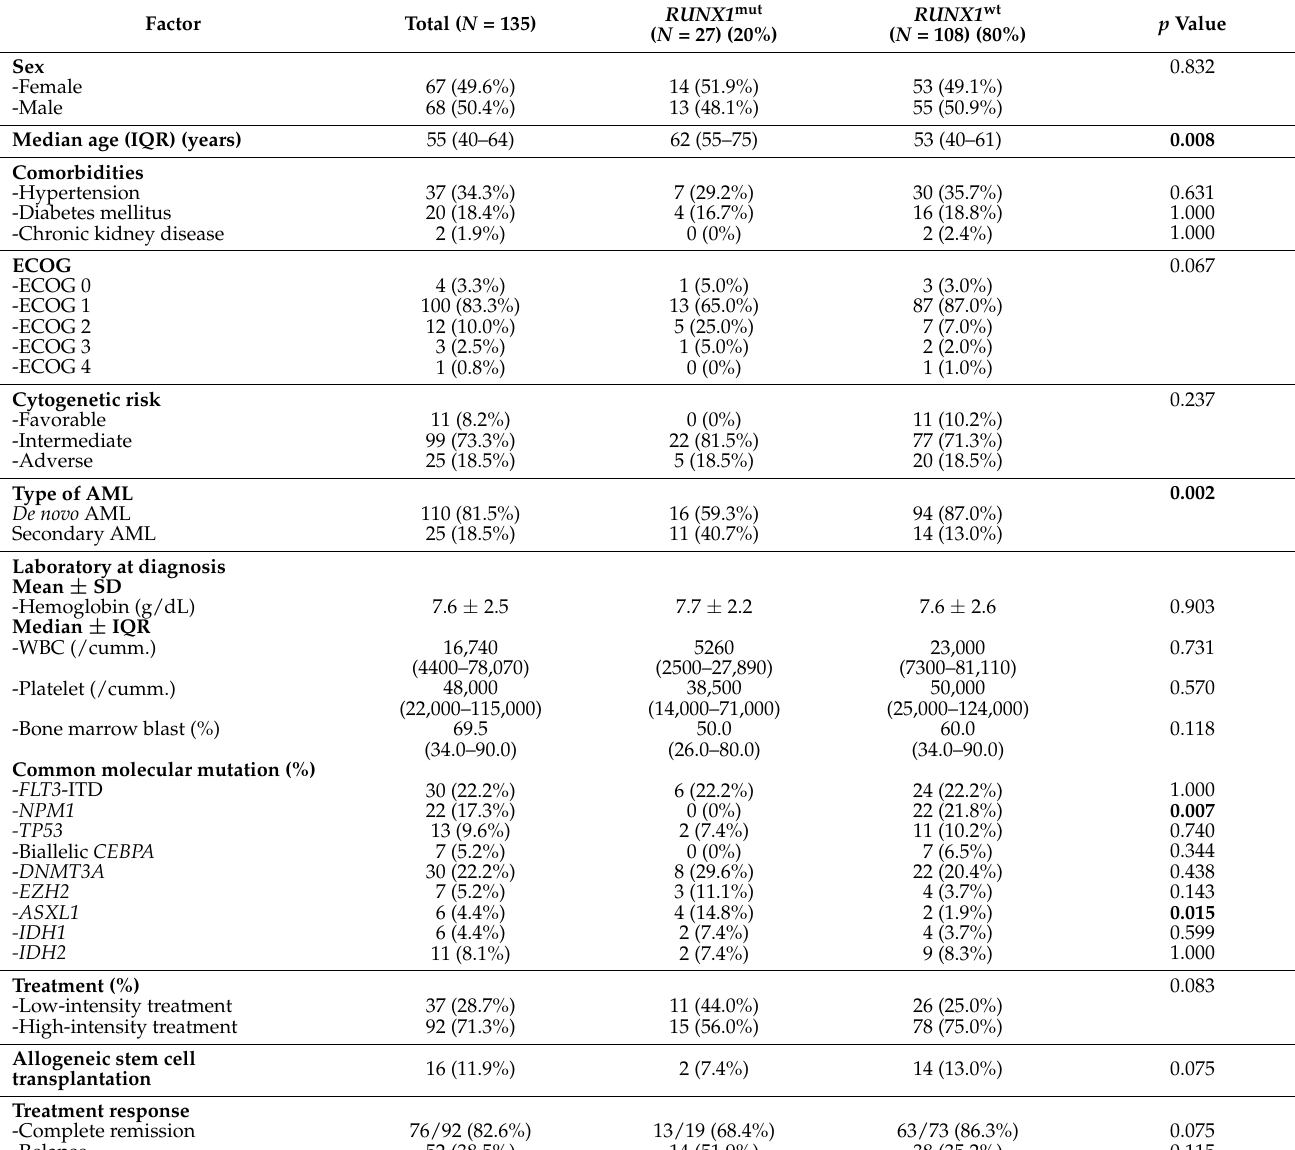
Table 1. Baseline characteristics of